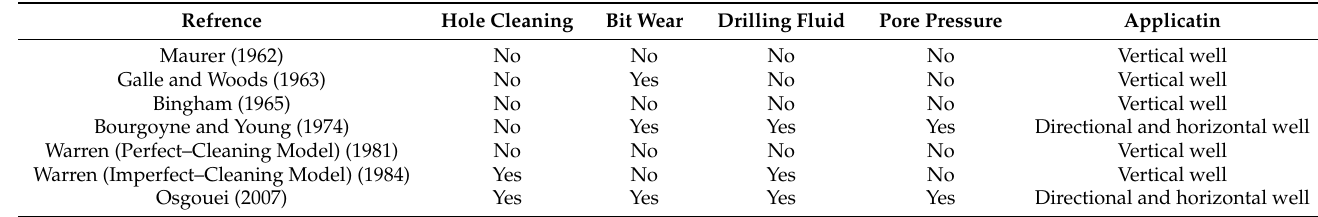
Table 2. Description of Empirical ROP